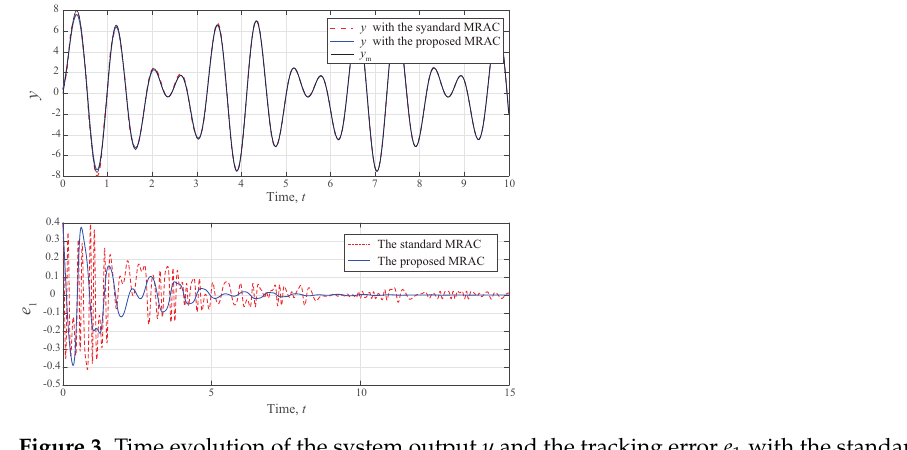
Figure 3. Time evolution of the system output y and the tracking error e 1 with the standard MRAC and the proposed MRAC.